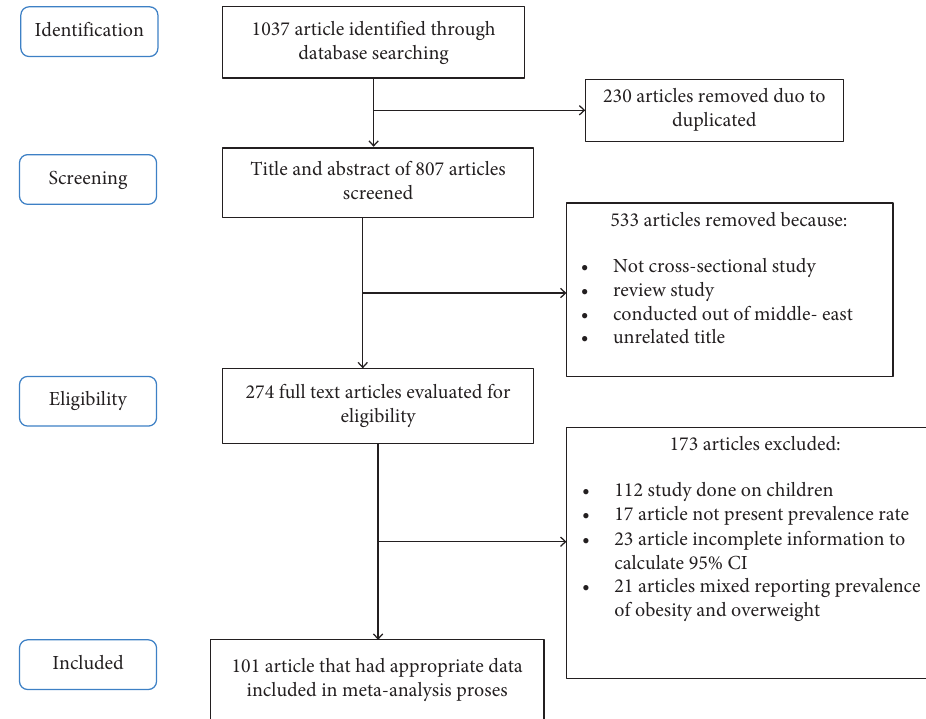
Figure 1: Flowchart of the study selection